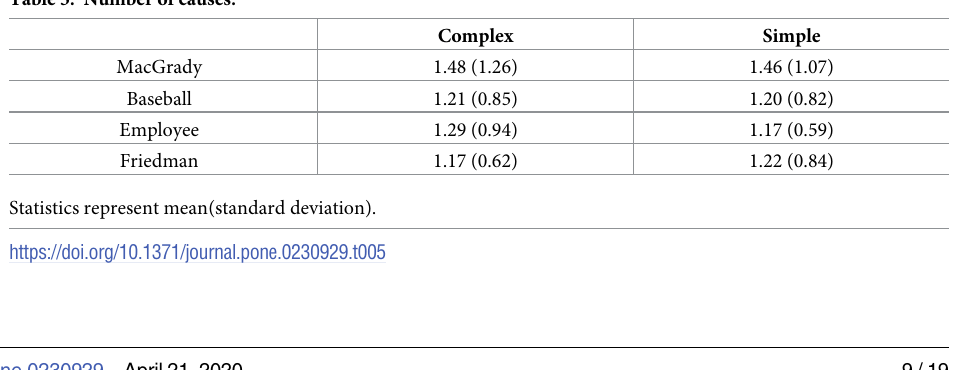
Table 5. Number of causes.